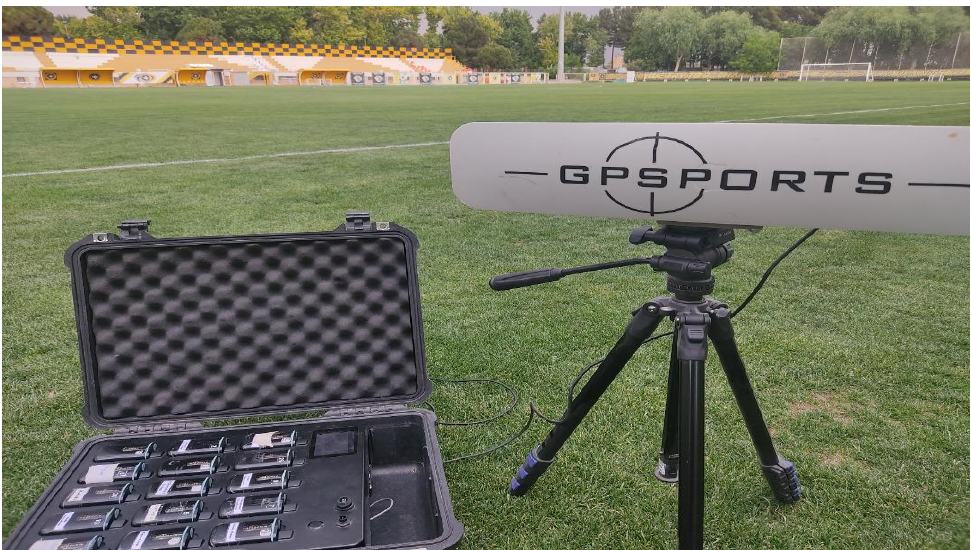
Figure 3. Tools used in each training session and matches.